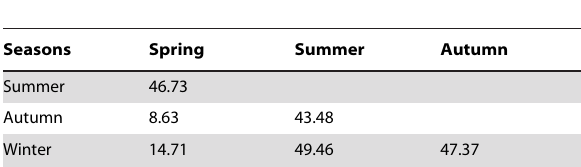
Table 1. Matrix of similarity indexes (PS) between seasons obtained for the main prey groups that constituted the diet of Cathorops spixii collected in Caraguatatuba Bight